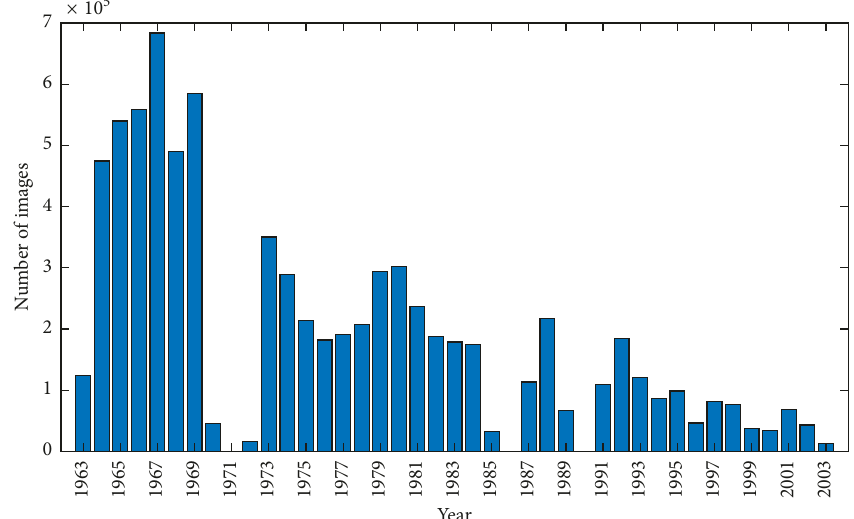
Figure 12: Number of pictures per